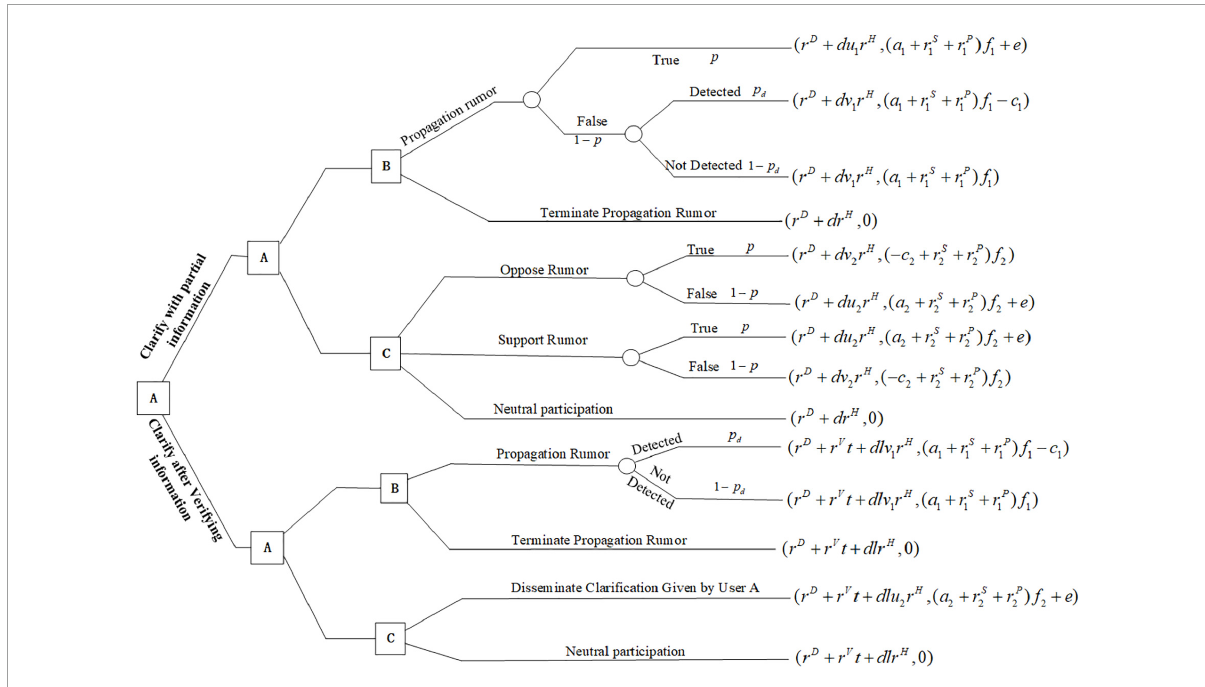
FIGURE5 The sequence of players moves in a rumor verification and clarification